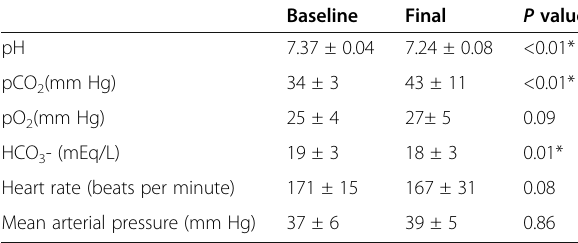
Table 1 Fetal variables (n=20 experiments) over time in ex utero support